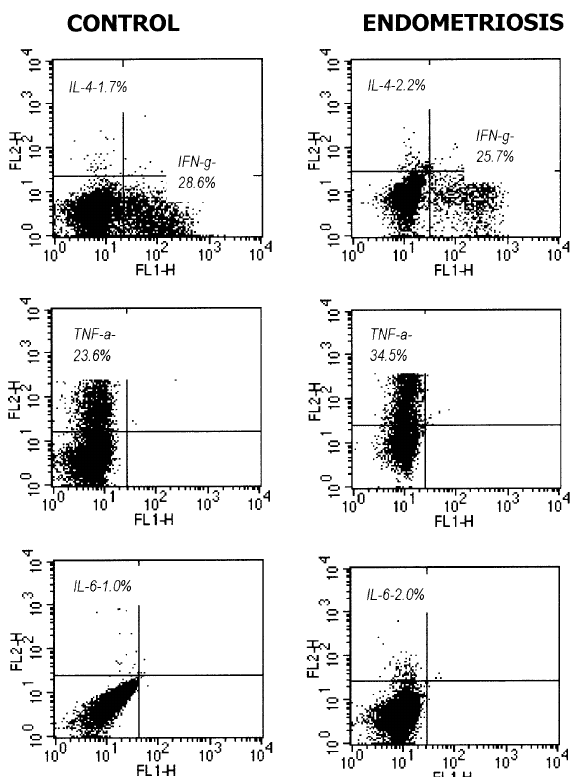
FIG. 1. Representative dot-plots obtained from analysis of intracellular deposits of IFN- g , IL-4, TNF- a and IL-6 in stimulated peripheral blood cells of healthy women (control) and women with endometriosis. The decreased expression of IFN- g and increased expression of TNF- a was observed in peripheral blood cells of women with